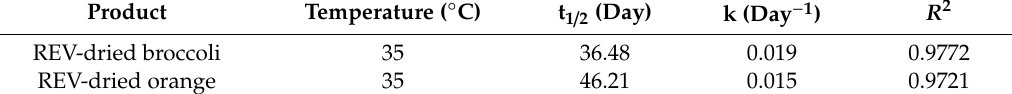
Table 3. Reaction rate constant (k) and half-life (t 1/2 ) vitamin C loss in REV-dried broccoli and orange.